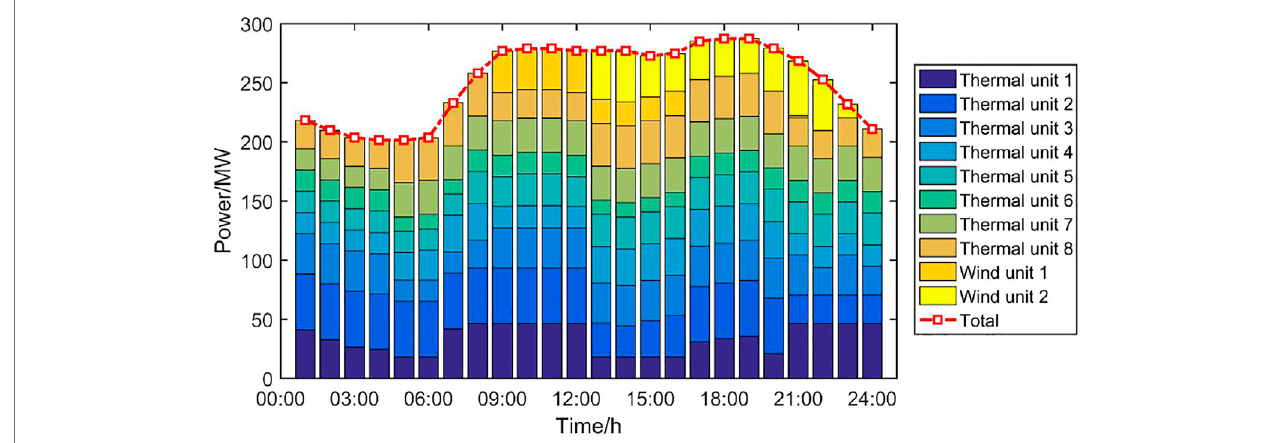
FIGURE 7 | Clearing energy of the market considering 10% wind power capacity.